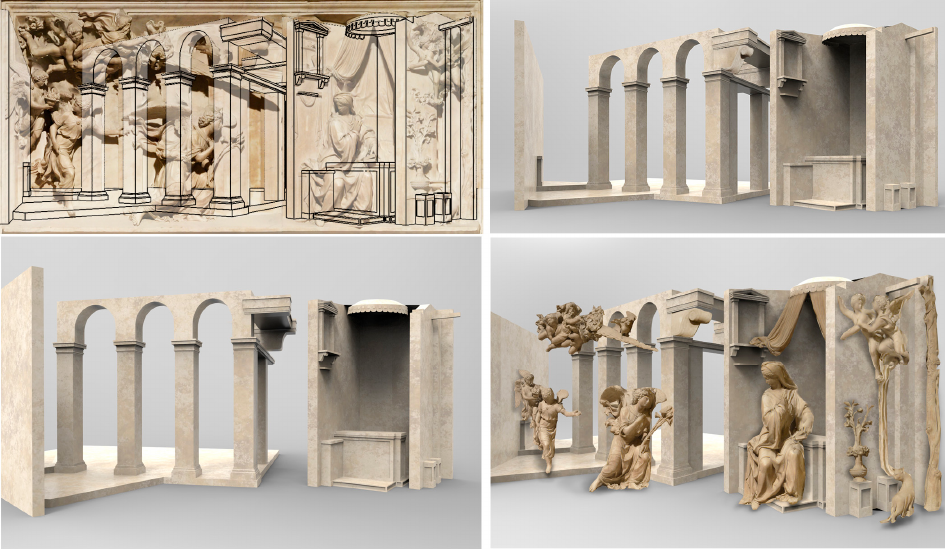
Figure 6. Views of the three-dimensional reconstruction of the space of the scenes represented in the relief according to the proposed